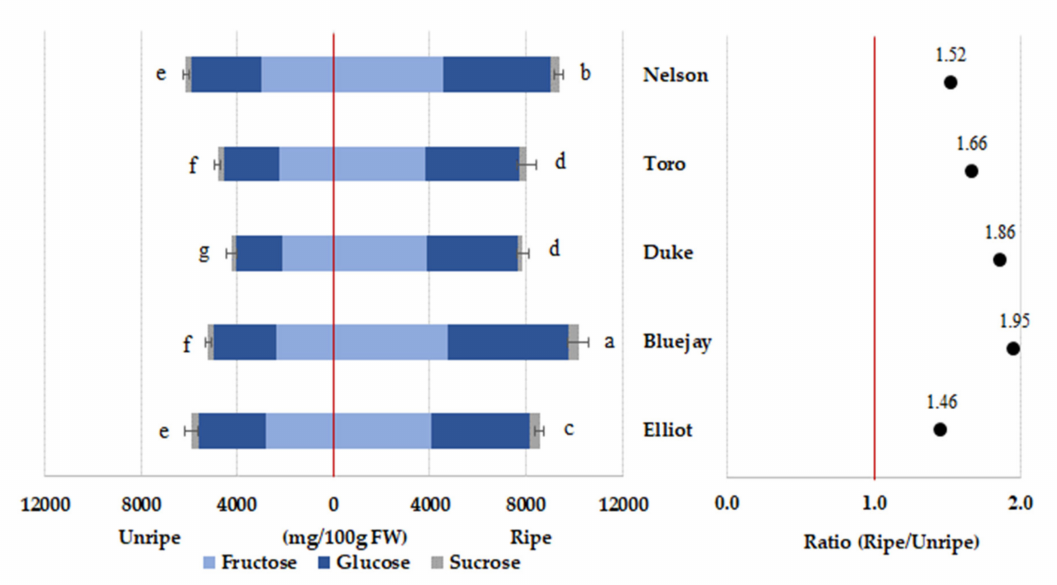
Figure 2. Di ff erent letters ( a – g ) are significant di ff erences by Duncan’s multiple range test ( p < 0.05).